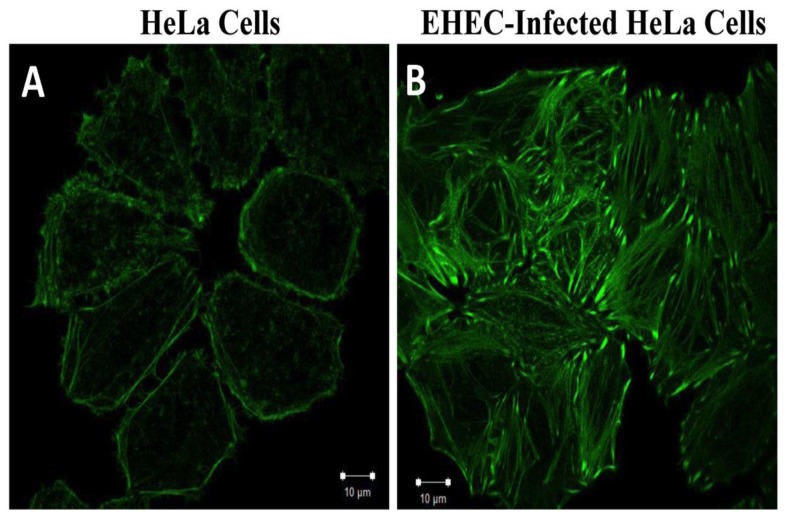
Confocal micrographs of actin filaments, FITC-labeled phalloidin (green), in the basal region of (A) HeLa cells without EHEC infection; (B) HeLa cells after infected by EHEC for 6 hours.The formation of the stress fibers in the basal region of HeLa cells after EHEC infection can be clearly observed in (B).